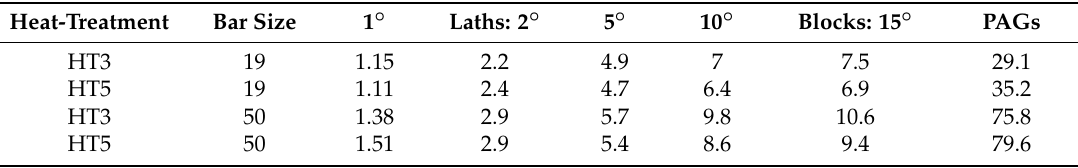
Table 2. Linear intercept sizes from EBSD measurements. Sizes from boundaries with misorientations of more than 1 ◦ , 5 ◦ and 15 ◦ . PAG sizes are determined using ARPGE reconstructions. The 15 ◦ values are used as block size and the 2 ◦ values as lath sizes. All size values are in µ m. Heat-Treatment Bar Size 1